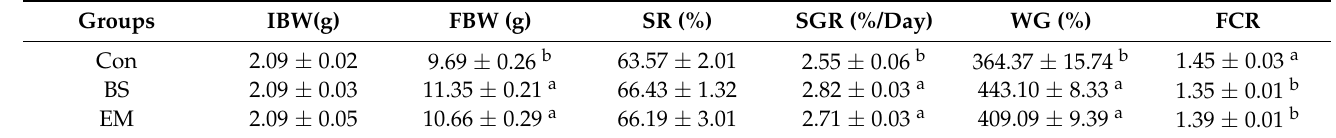
Table 2. Effects of probiotics on growth performance of M. rosenbergii .